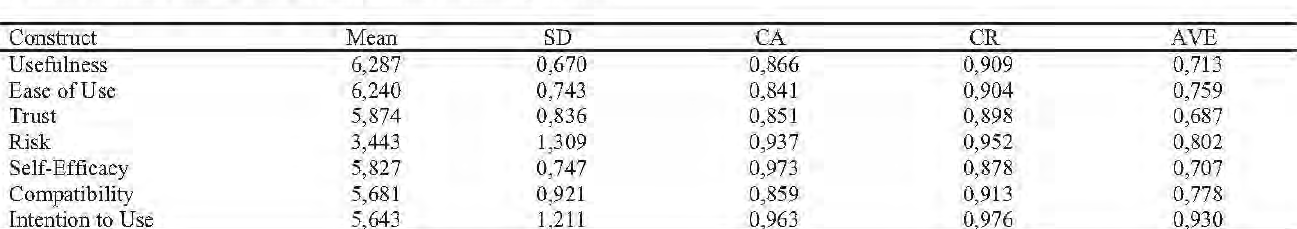
Table 7: Mean, standard deviation, and reliability